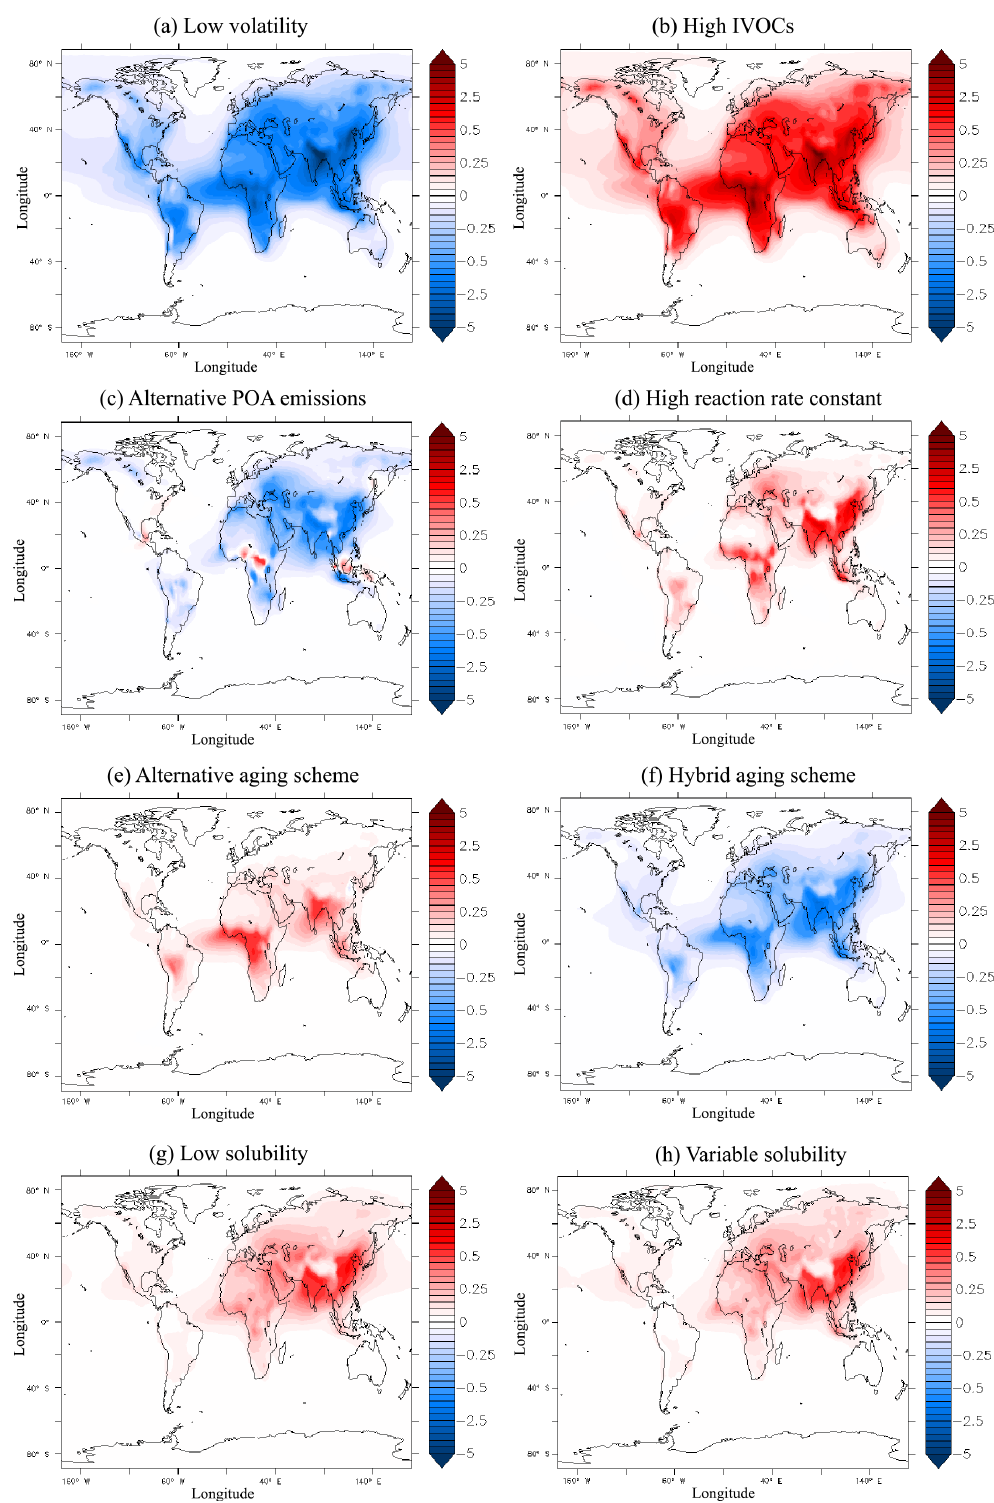
Figure 6. Absolute changes (inµgm − 3 ) of the average surface SOA concentrations from IVOCs (SOA-iv) between the reference and the (a) low-volatility, (b) high IVOCs, (c) alternative POA emissions, (d) high reaction rate constant, (e) alternative aging scheme, (f) hybrid aging scheme, (g) low-solubility, and (h) variable solubility simulations during the period 2001–2010. A positive change indicates an increase in the sensitivity